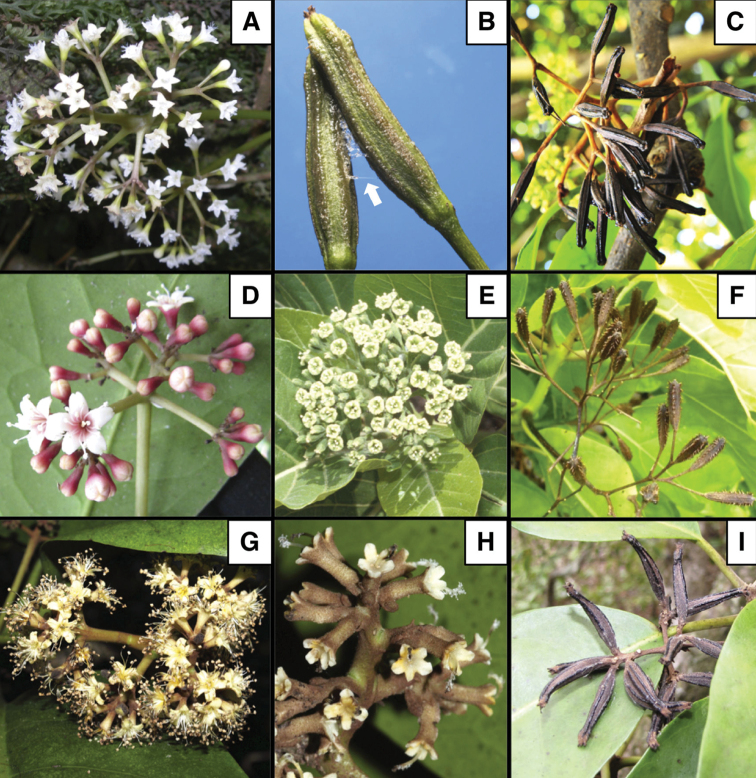
Field images for representative species of Ceodes, Pisonia and Rockia (Nyctaginaceae) from the Pacific Islands ACeodes
taitensis. Branch with pistillate flowers BCeodes
brunoniana. Ripe anthocarps (fruits) exuding sticky secretions (arrow) C, DCeodes
umbellifera. Branch with ripe anthocarps (C) and staminate flowers at anthesis (D) E, FPisonia
grandis R.Br. Staminate flowers at anthesis (E) and ripe anthocarps (F) G–IRockia
sandwicensis. Staminate (G) and pistillate (H) flowers at anthesis and ripe anthocarps (I) Photo credits: A, F by J.-Y. Meyer B by L. Jensen C by C.-I Peng D, E, I by F. Starr and K. Starr G, H by K. Magnacca.